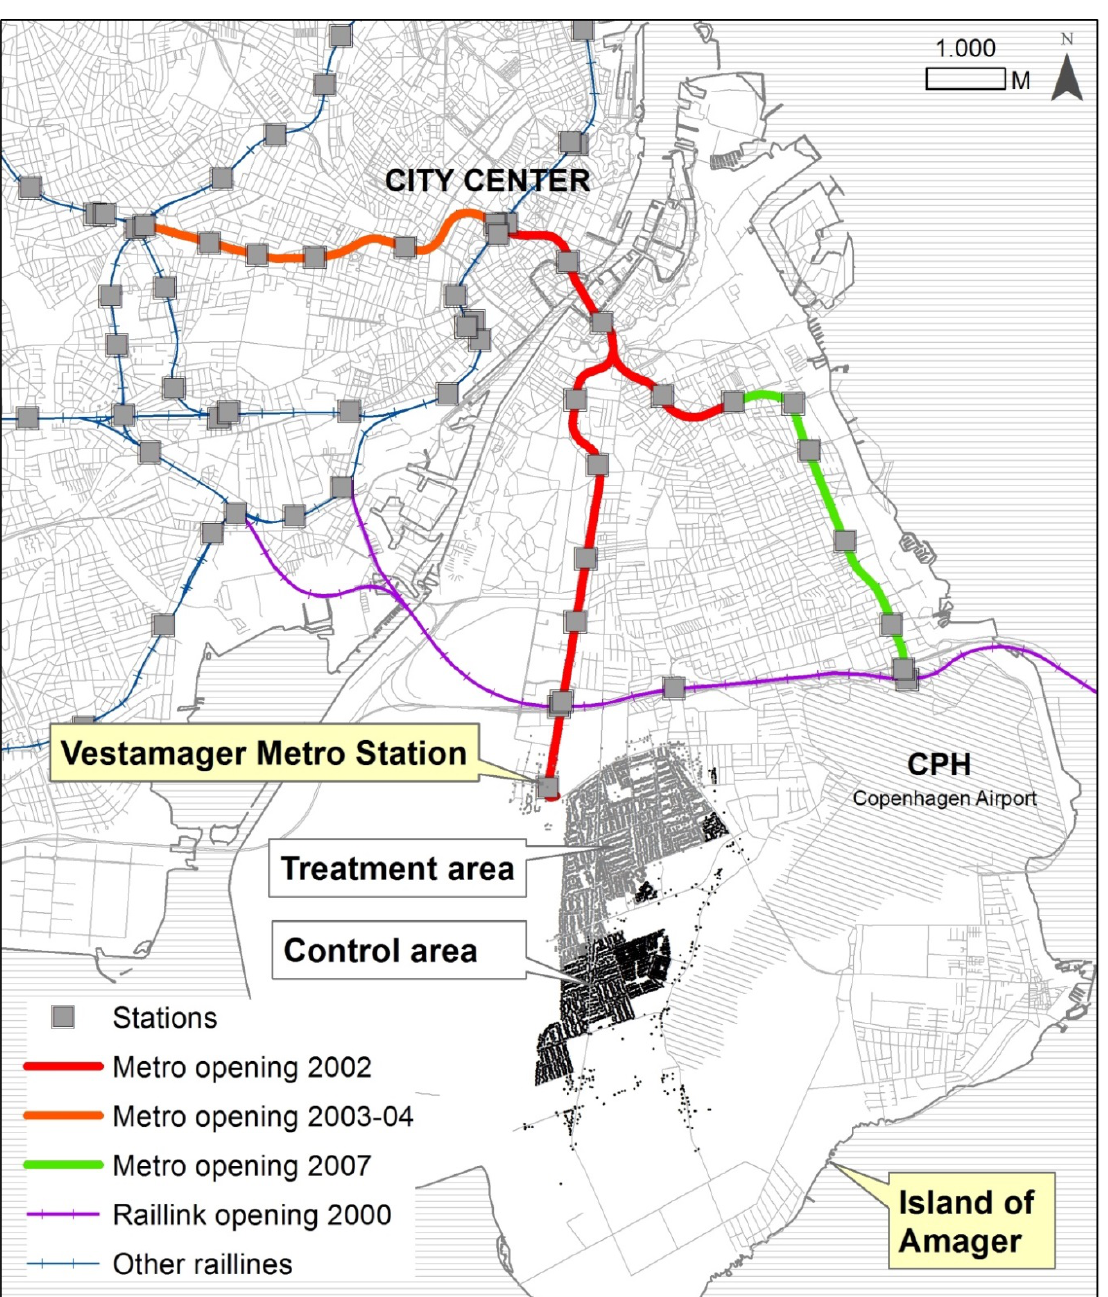
Figure 1. Vestamager Metro Station and addresses within the treatment and control